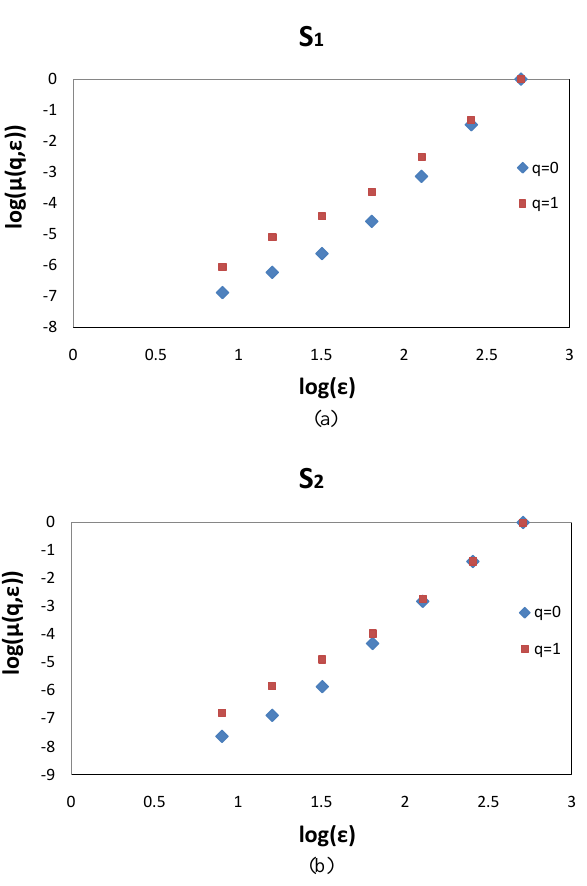
Fig. 9. Multifractal dimensions D q associated to the SEM image of sample S 1 for moments order q between − 5 and 5.